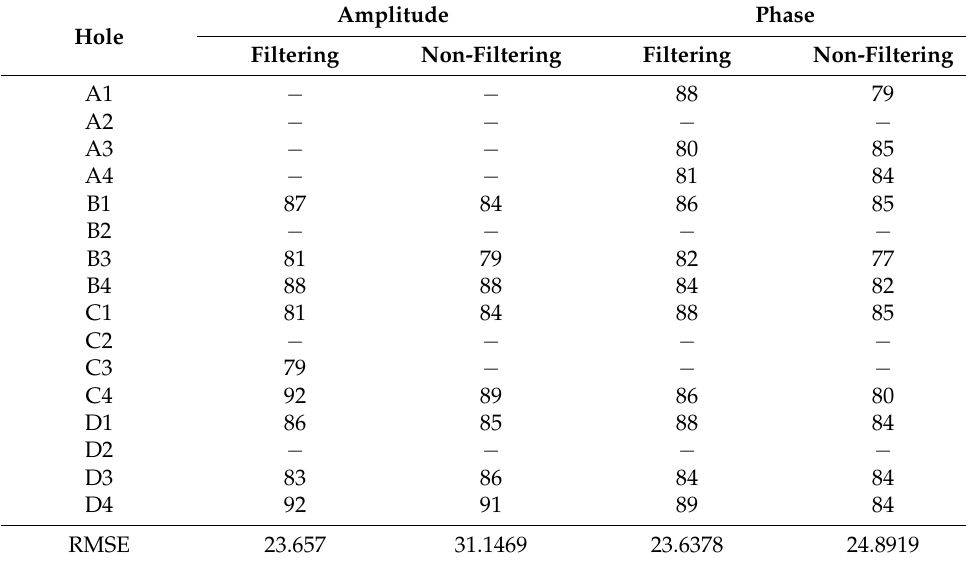
Table 2. RMSE values for the filtering and non-filtering of amplitude and phase images. Amplitude Phase Hole Filtering Non-Filtering